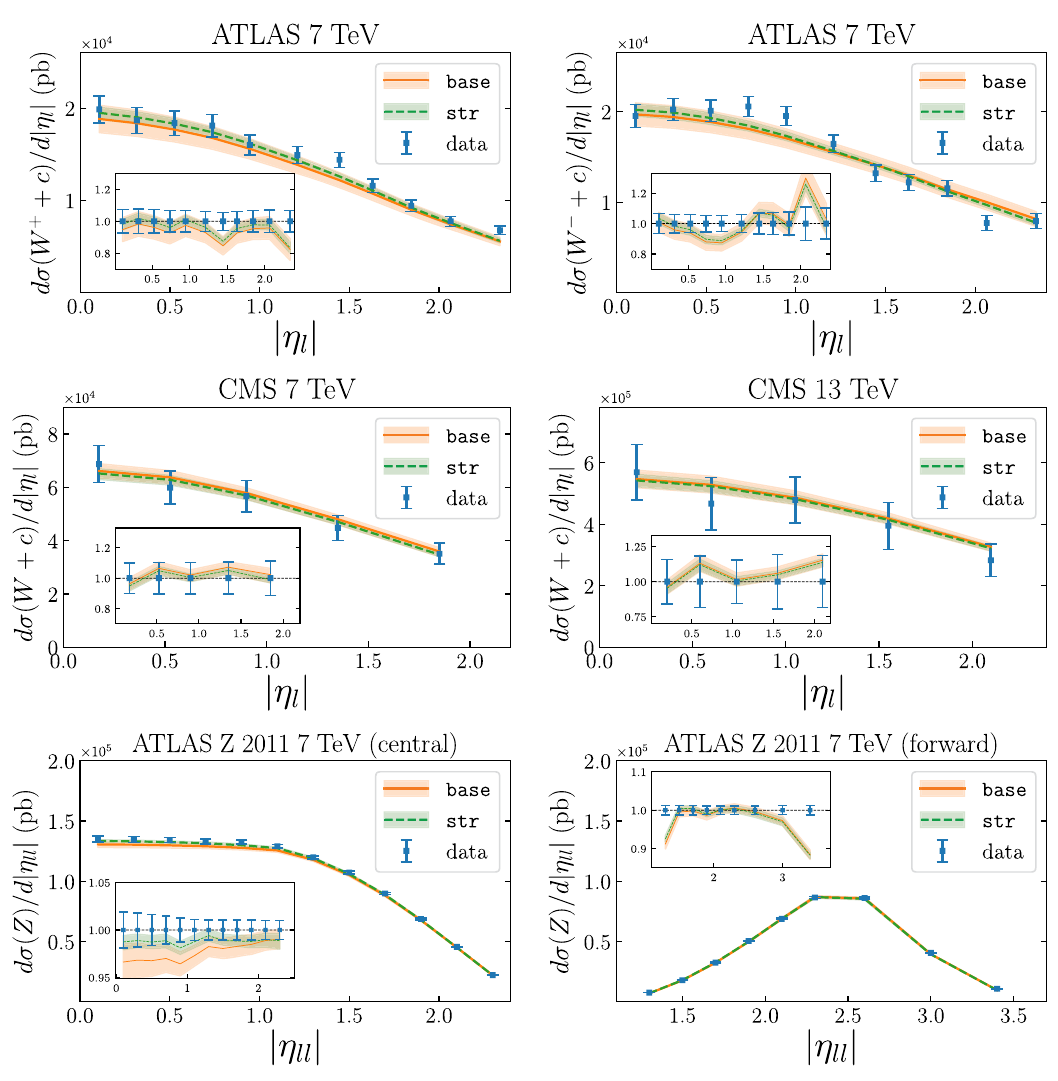
Fig. 4 Comparison between theoretical predictions and experimental data for some of strangeness-sensitive proton collider measurements used in this work. Top: the W + c lepton rapidity distributions (sepa- rately for W + and W − ) corresponding to the ATLAS measurement at 7 TeV [16]. Middle: the W + c lepton rapidity distributions (sum of